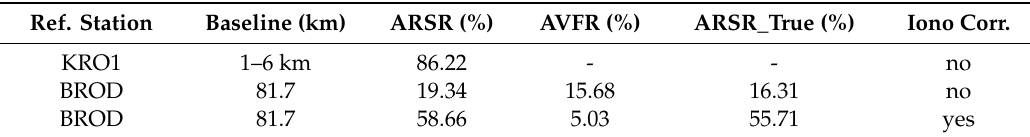
Table 3. Statistics of real-time solutions.